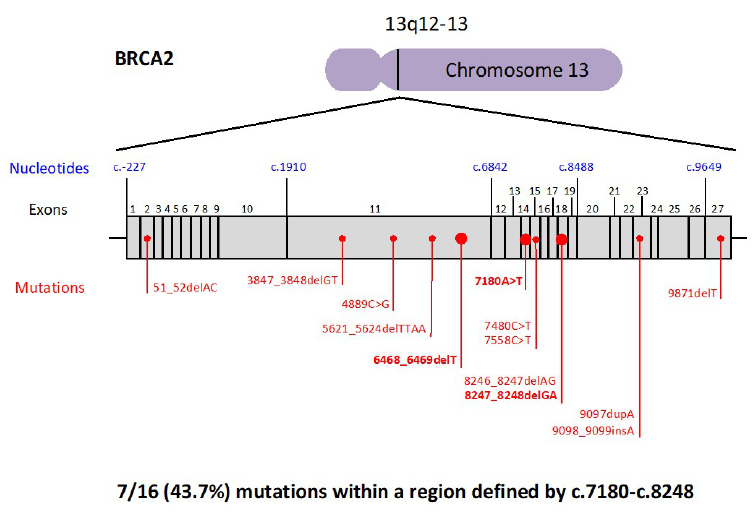
Figure 3. Distribution of BRCA2 pathogenic variants. The mutations detected twice are shown in bold. Table 2. The Modena Criteria (AIOM Guidelines 2018).